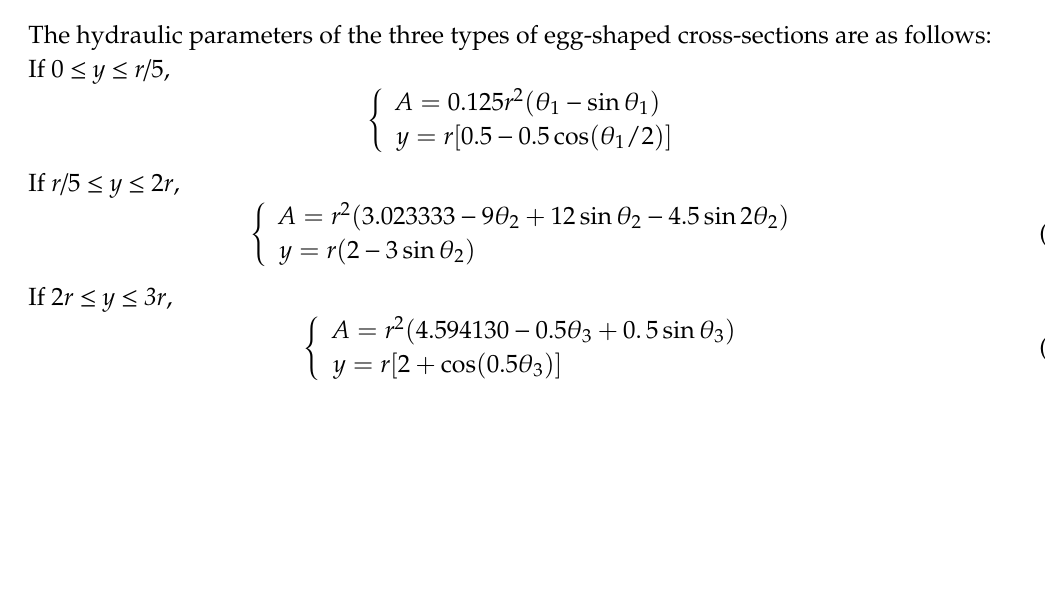
Figure 3. Cross-section of an egg-shaped conduit (( a ) 0 ≤ y ≤ r /5, ( b ) r /5 ≤ y ≤ 2 r , ( c ) 2 r ≤ y ≤ 3 r ).